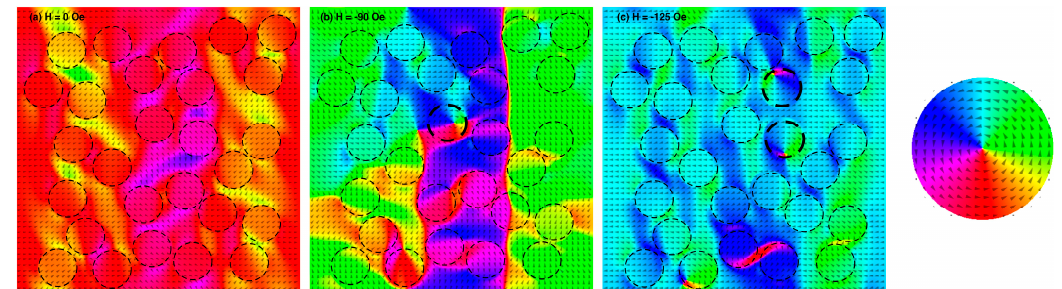
Figure 6. (Colour online) Micromagnetic simulations of a portion of a BN system with a size of 2.6 μ m × 2.6 μ m. Colours and arrows indicate the direction of the magnetisation (see legend to the right). The dashed circles identify the Co dots inside the Ni 80 Fe 20 matrix. ( a ) At magnetic remanence after saturation at a positive field (aligned horizontally to the right); ( b ) at a field of − 90 Oe (aligned horizontally to the left); ( c ) at a field of − 125 Oe (aligned horizontally to the left). In ( b , c ), the thicker circles indicate dots where a vortex magnetisation has developed.